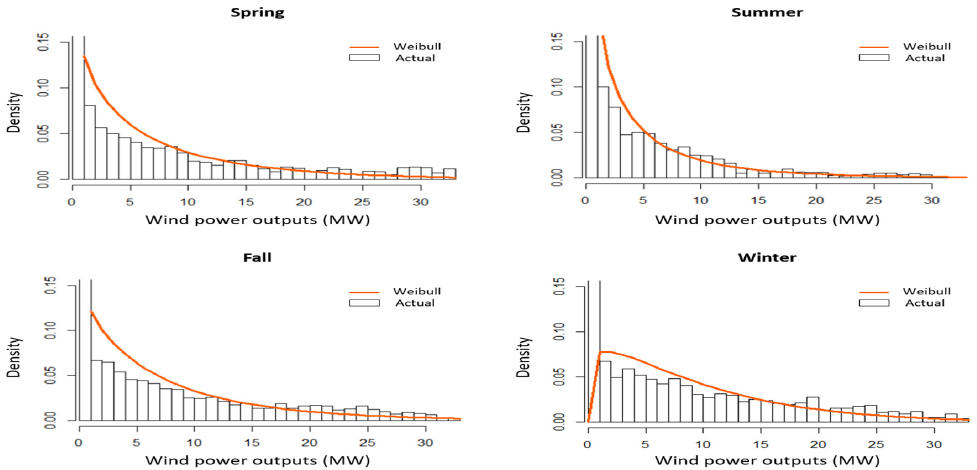
Figure 4. Seasonal Weibull distributions of wind power output.